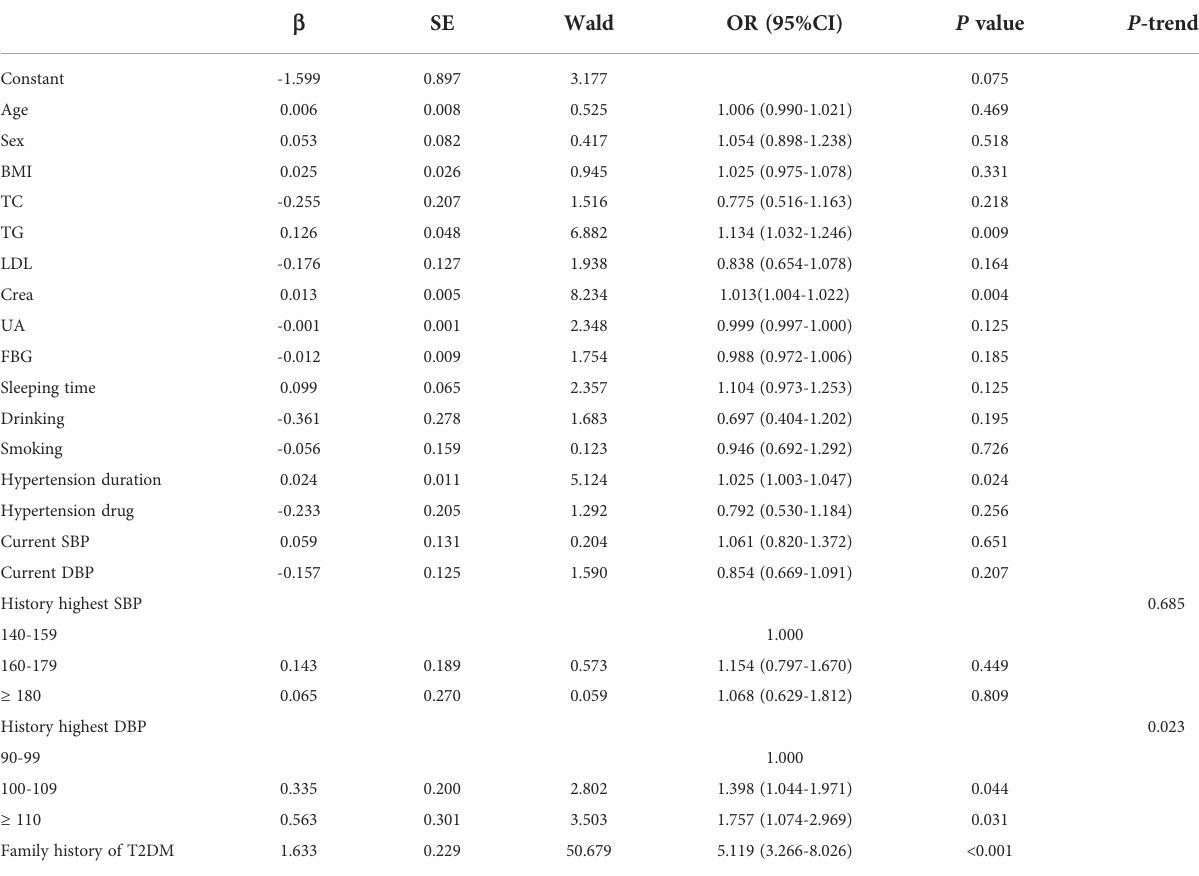
TABLE 3 Multiple logistic regression analysis of the risk of T2DM in hypertension subjects.